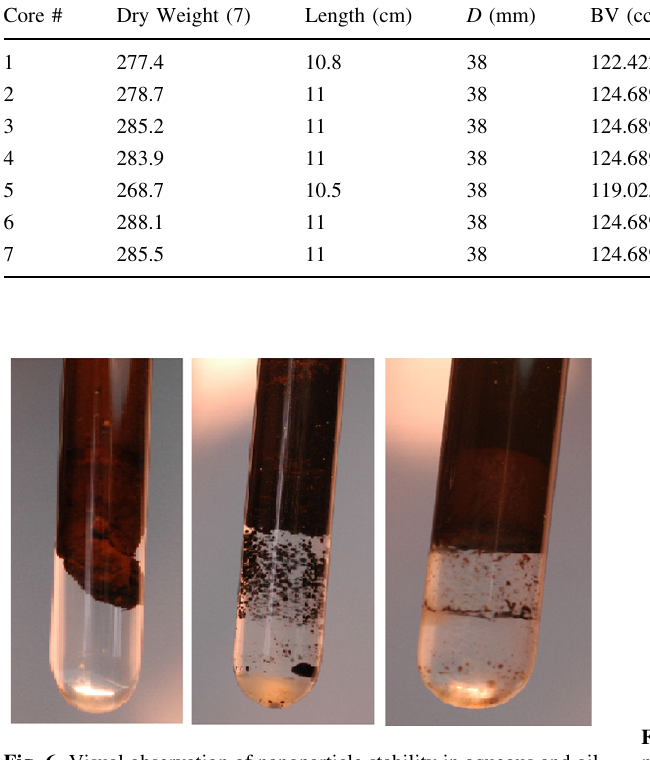
Fig. 6 Visual observation of nanoparticle stability in aqueous and oil phases